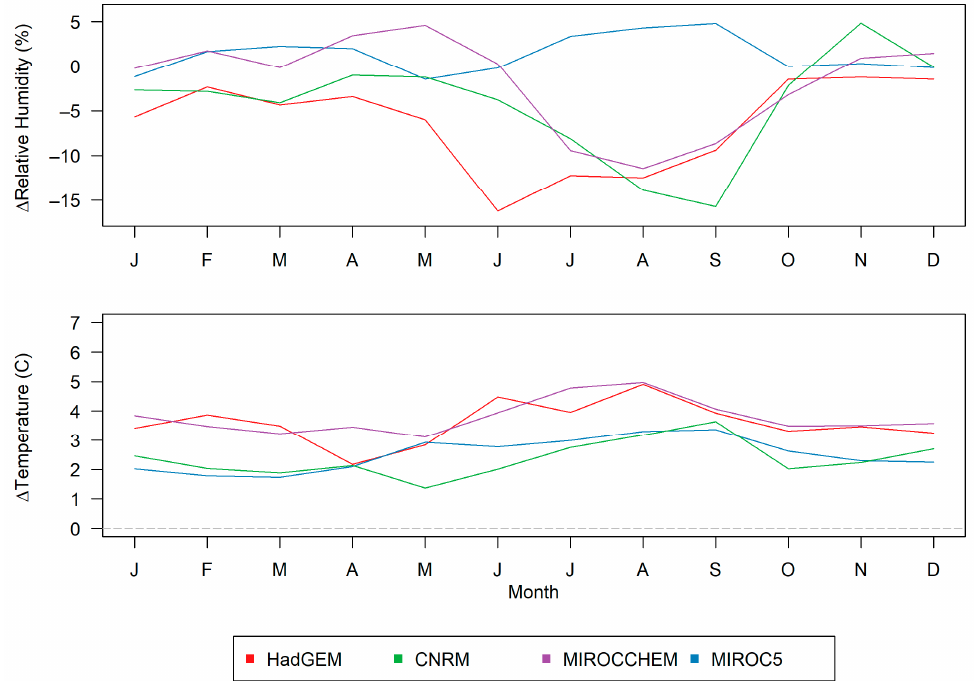
Figure 3. Average monthly temperature and relative humidity departure from historical (1970–1999) 1 predicted by the four GCMs selected to model future fire weather conditions. These four GCMs represent a full range of predicted climate futures and were downscaled over the study